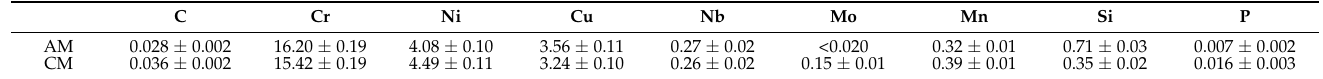
Figure 1. 3D representation of the AM specimens and a photograph of the building plate with the built parts. Cylinders and parallelepipeds were built. Cubic samples were machined from the parallelepipeds after building. Table 1. Chemical composition of the AM and CM samples (Fe balance, wt.%. The S amount was lower than 0.005 wt.% for both the AM and CM samples of MSS. The amounts of N and O were 310 ± 6 (140 ± 2) ppm and <2 (<2) ppm for the AM (CM) samples,